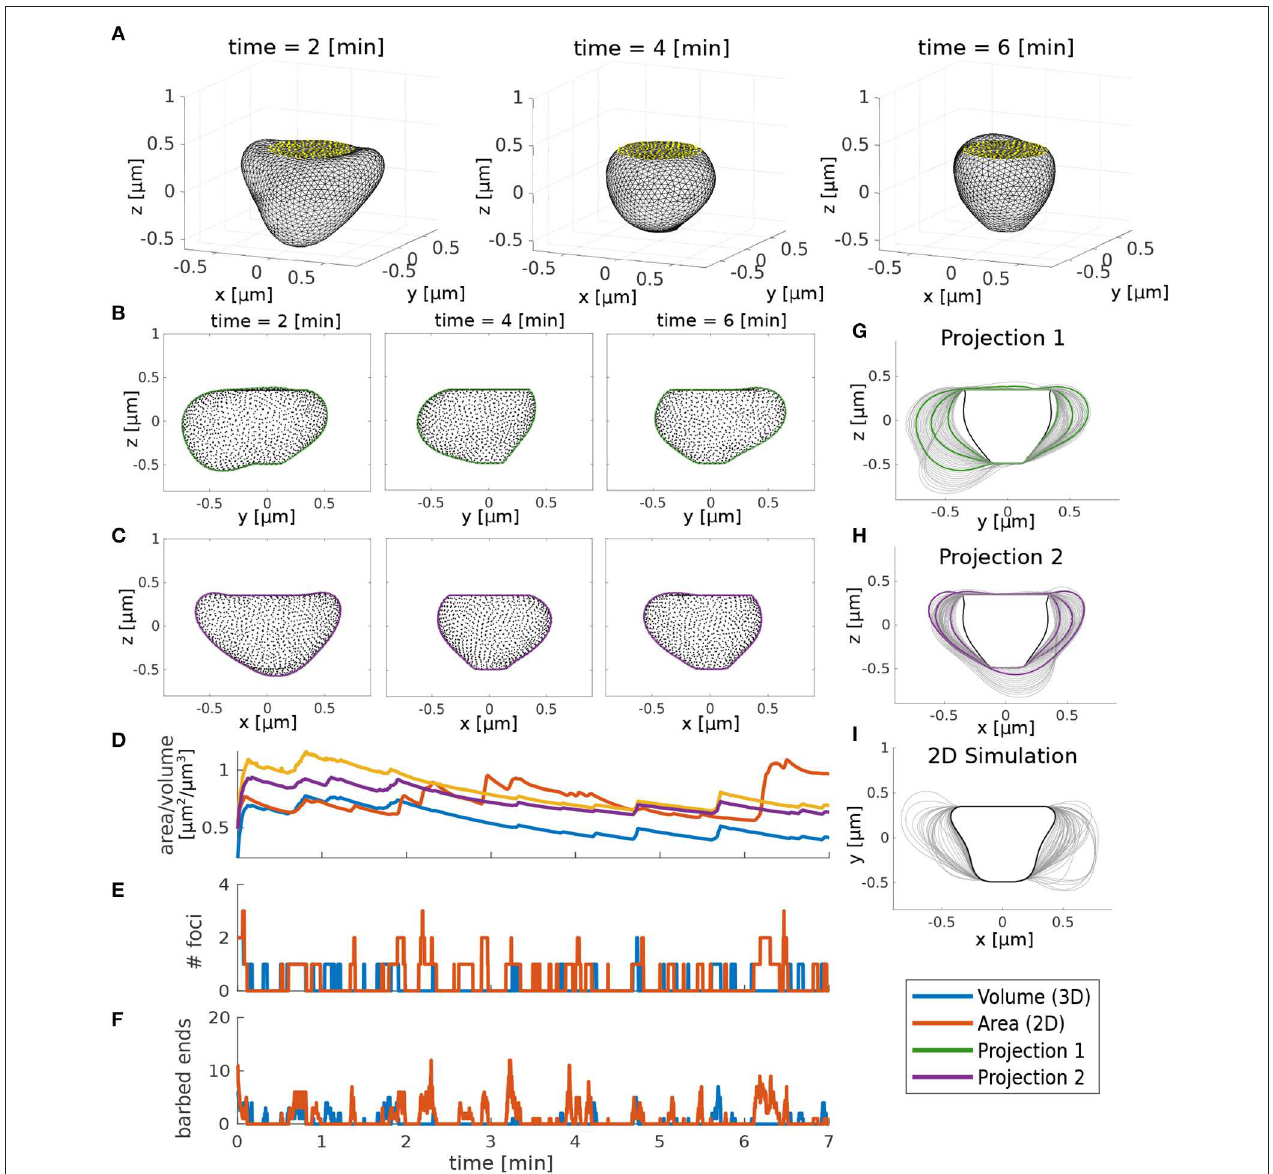
FIGURE 12 | Comparison between 3D and 2D model. (A) 3D simulation snapshots at different time points. Yellow dots indicate the PSD. (B,C) Projection of the 3D simulation to two 2D views. Black dots are the corresponding 3D vertices and lines are a fitted boundary around these points. (D) Time evolution of volume (3D simulation) and area (2D simulation and 2D projections). (E) Number of actin foci during the 2D/3D simulation. (F) Mean number of barbed ends. (G,H) Spine shapes emerging from the 2D projections of the 3D model in time intervals of 10 s. Black lines represent the initial shape and green and purple lines correspond to the snapshots in (B,C) , respectively. (I) Spine shapes emerging from 2D simulation of the model. Parameters for 3D and 2D simulations are in Table 1 except that in 3D δ s 0.06, ζ 0.004, and φ 30, and in 2D ζ = = = =